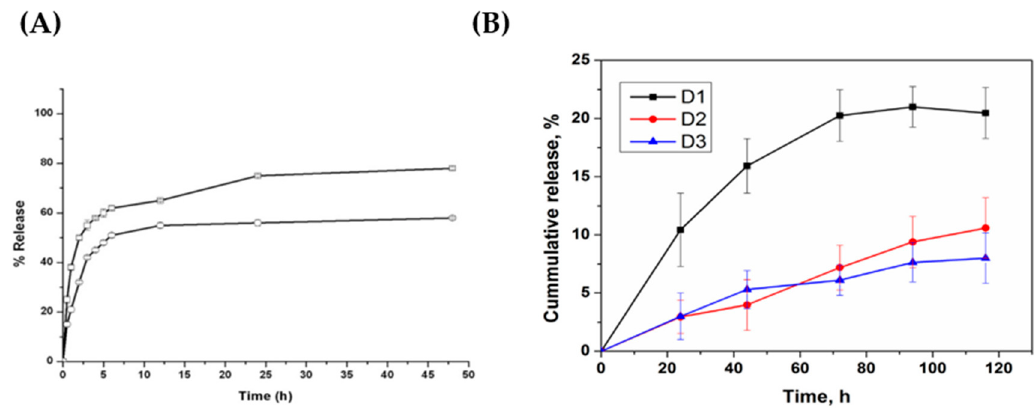
Figure 7. ( A ) The cumulative release of cisplatin from (ALG/PRO) n capsules of 2 (open squares) and 3 (open circles) bilayers; ( B ) the cumulative release of DOX from DS/PARG-based capsules. D1: Initial and final capsule size of 550 nm, D2: Initial and final capsule size of 550 and 290 nm, respectively, and D3: Initial and final capsule size of 290 nm. All three sets of capsules shared an equal DOX feeding concentration, but were incubated for 1 h at either 25 °C or 90 °C for D1/D3, and D2, respectively. Figure A taken with permission from Reference [102], copyright© 2015, Elsevier. Figure B taken with permission from Reference [103], copyright© 2019, Elsevier.